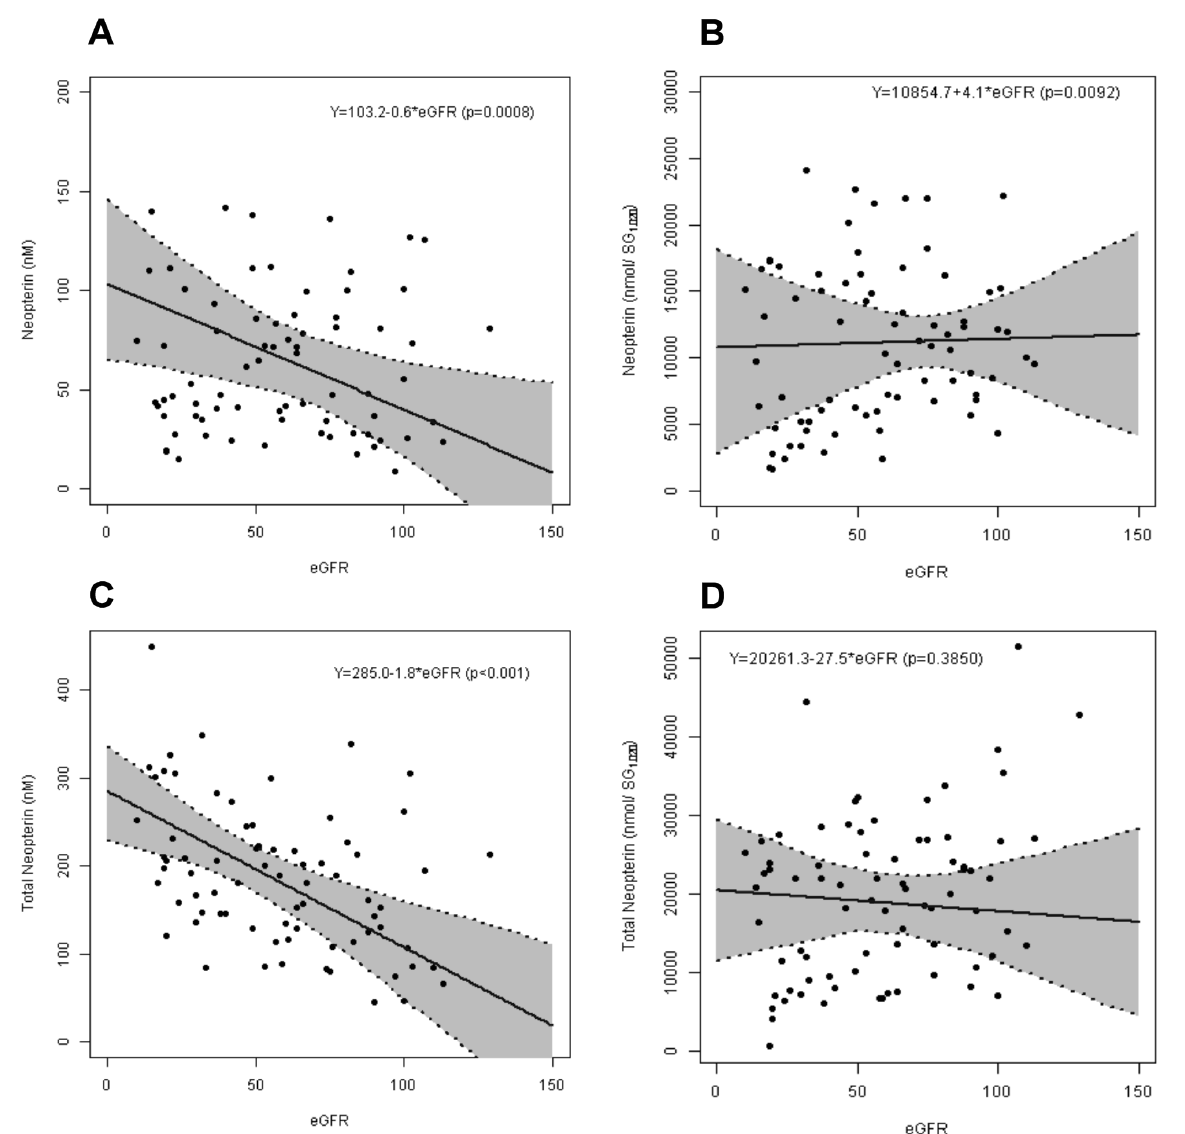
Figure 5: Plasma (A, C) and urinary (B, D) neopterin (A, B) and total neopterin (C, D) correlations against eGFR in septic patients. Plasma neopterin and total neopterin decrease as eGFR increases, whereas, urinary neopterin and total neopterin remain less effected by kidney